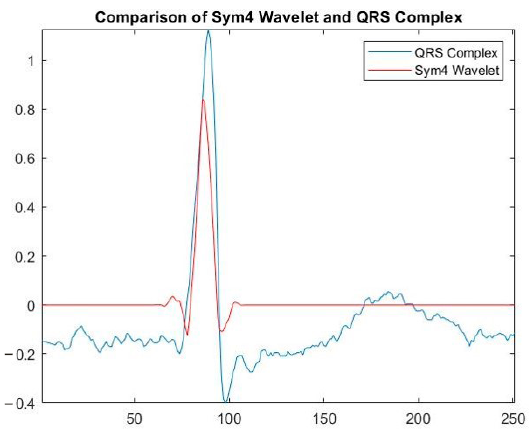
Figure 8. Symlet repeating the shape of the R-peak on the ECG signal.